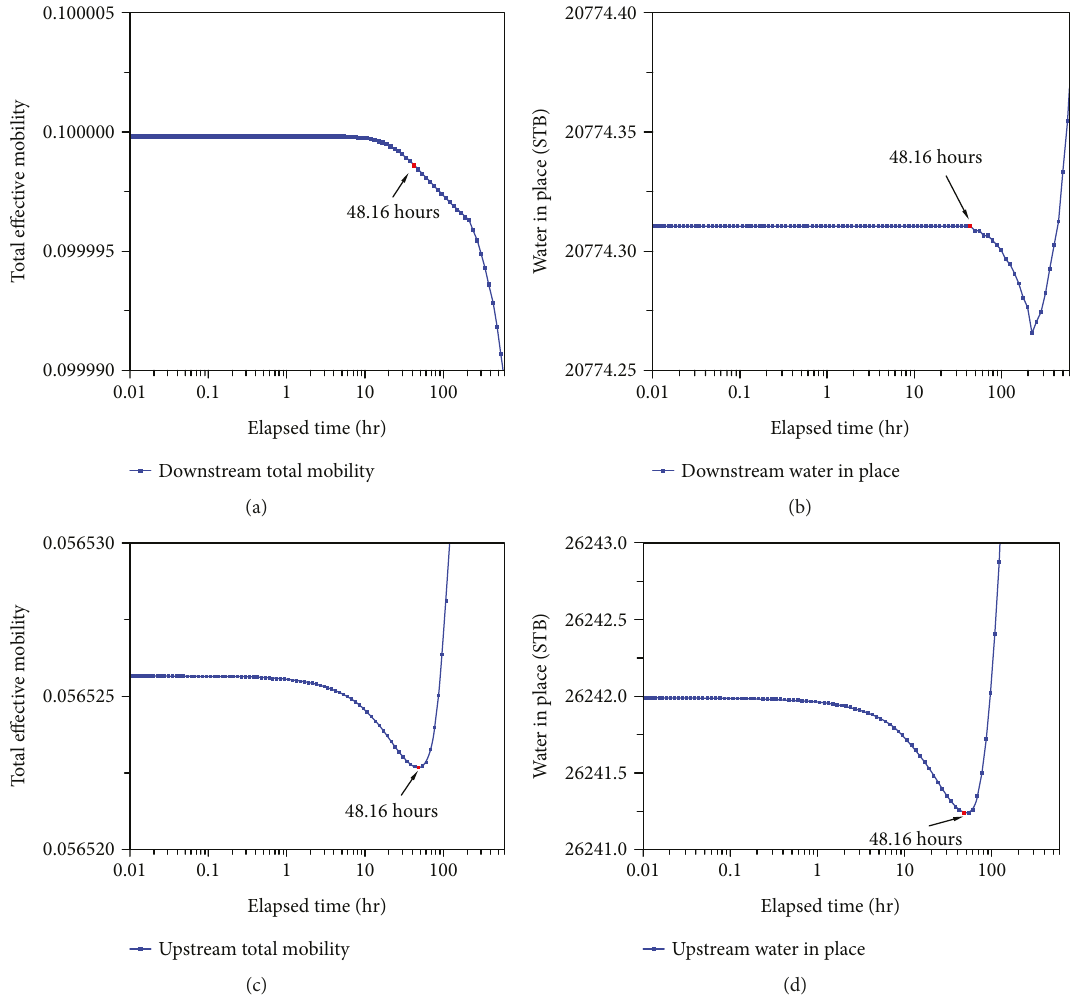
), before 48.16 hr, f